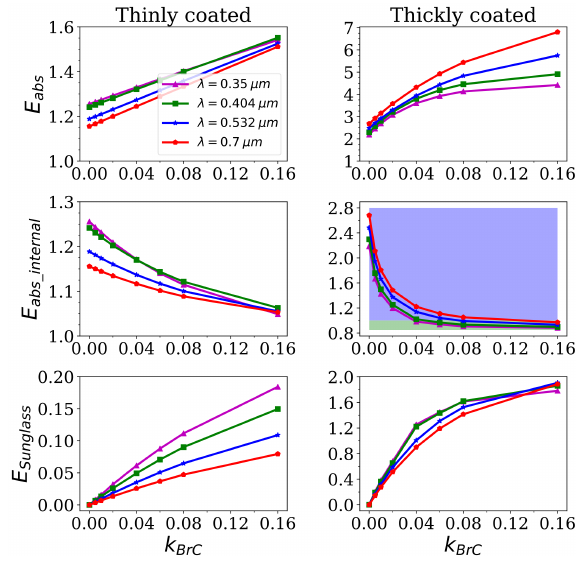
Figure 2. Effects of k BrC on specific enhancement ( n s = 200). For thinly coated BC, D f = 2 . 2 and f BC = 40%; for thickly coated BC, D f = 2 . 6 and f BC = 5%. The blue shading represents the E abs_internal of larger than 1, while the green shading describes the range of E abs_internal of less than